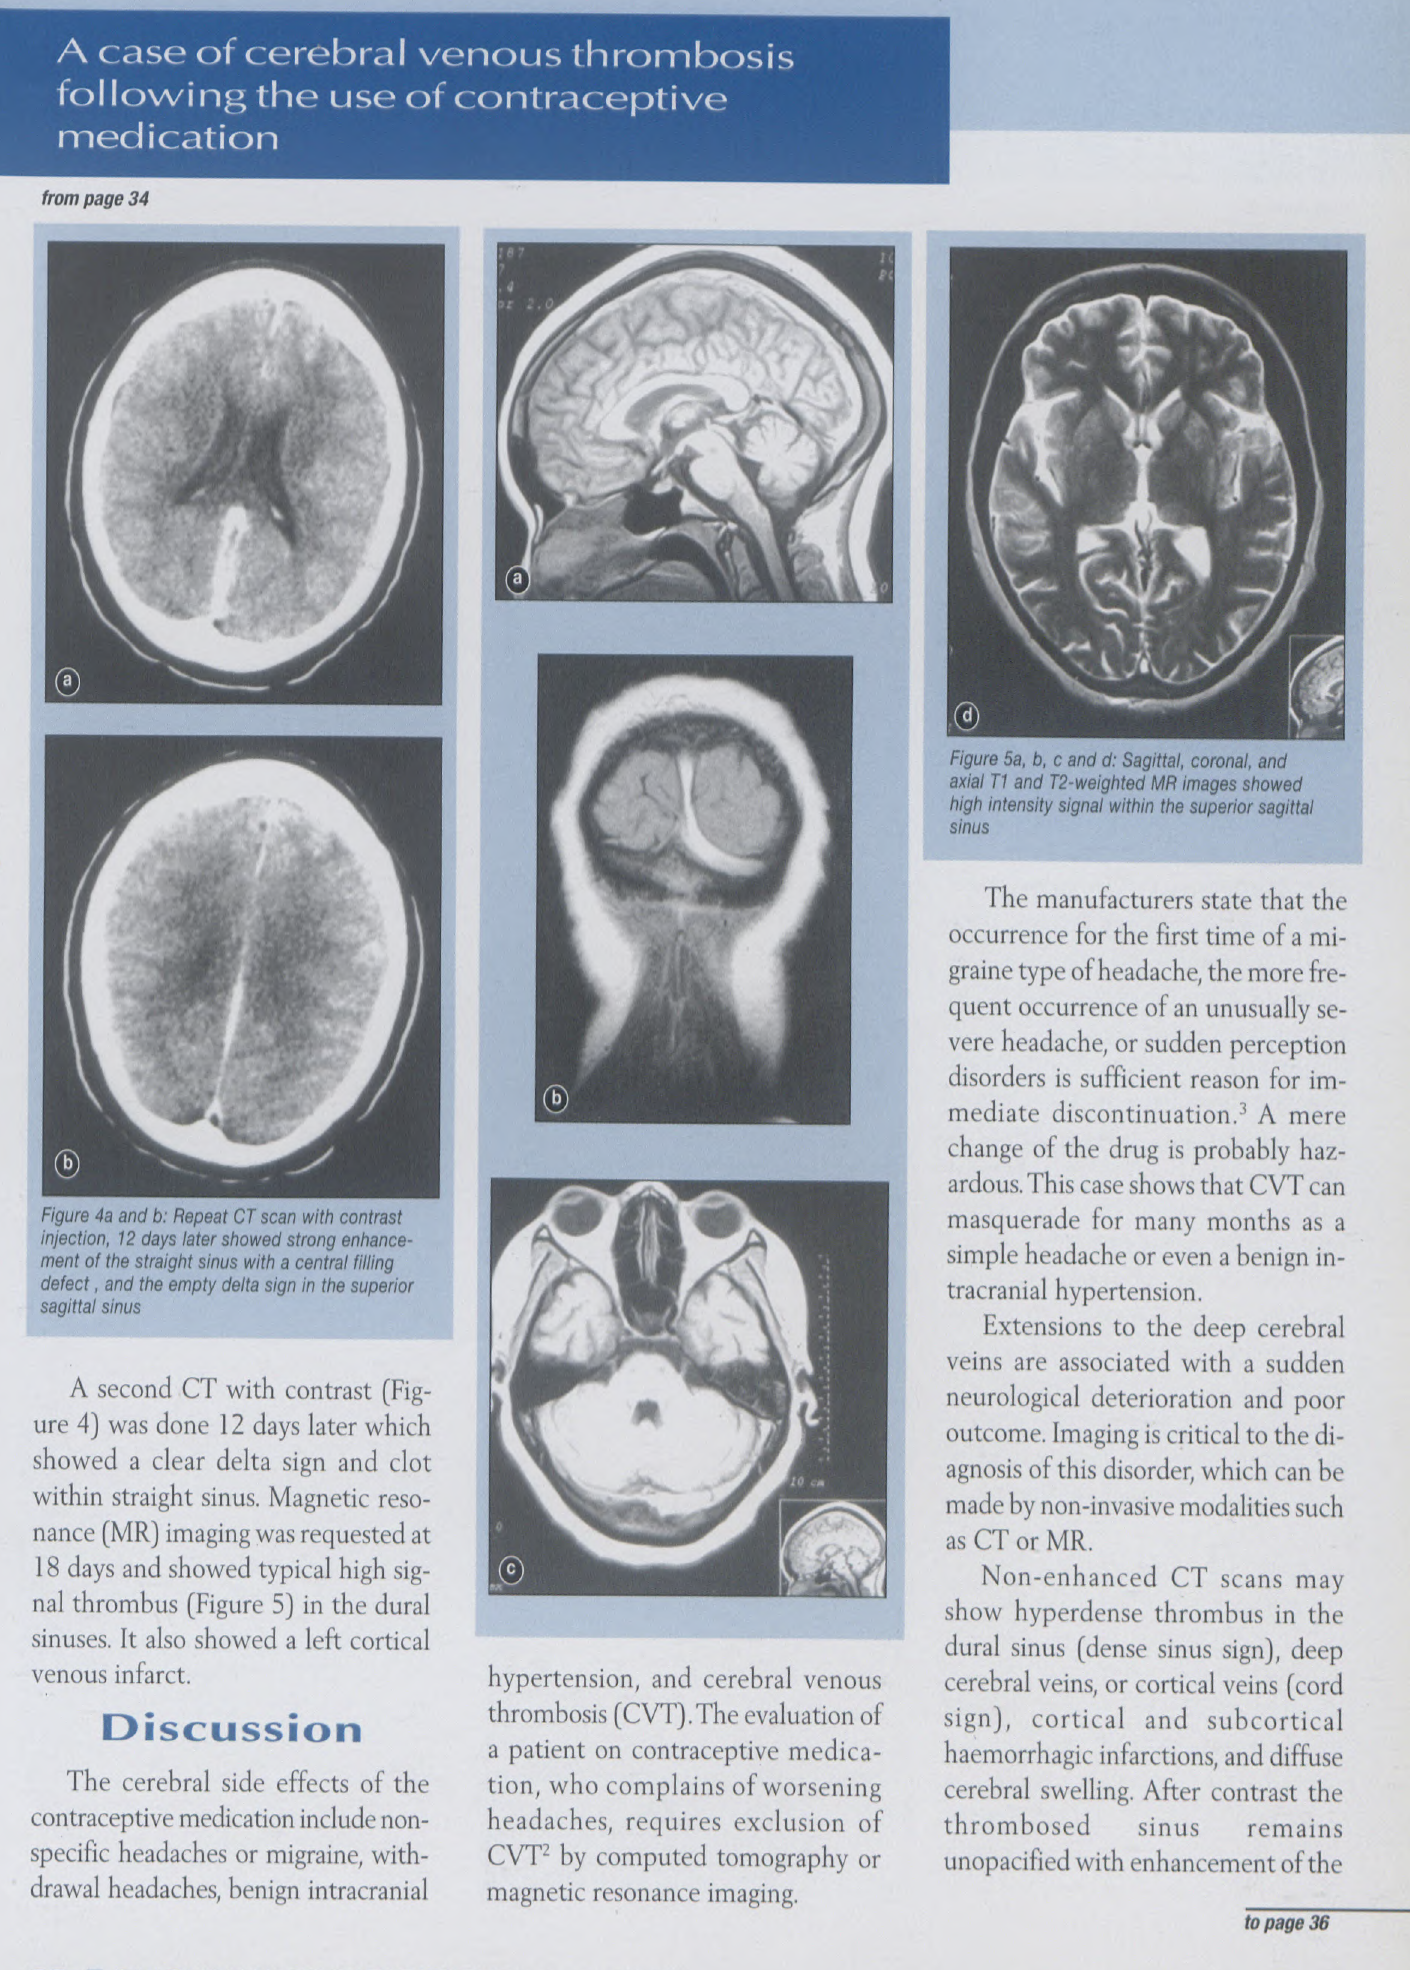
Figure 4a and b: Repeat CT scan with contrast injection, 12 days later showed strong enhance- ment of the straight sinus with a central filling defect, and the empty delta sign in the superior sagittal sinus